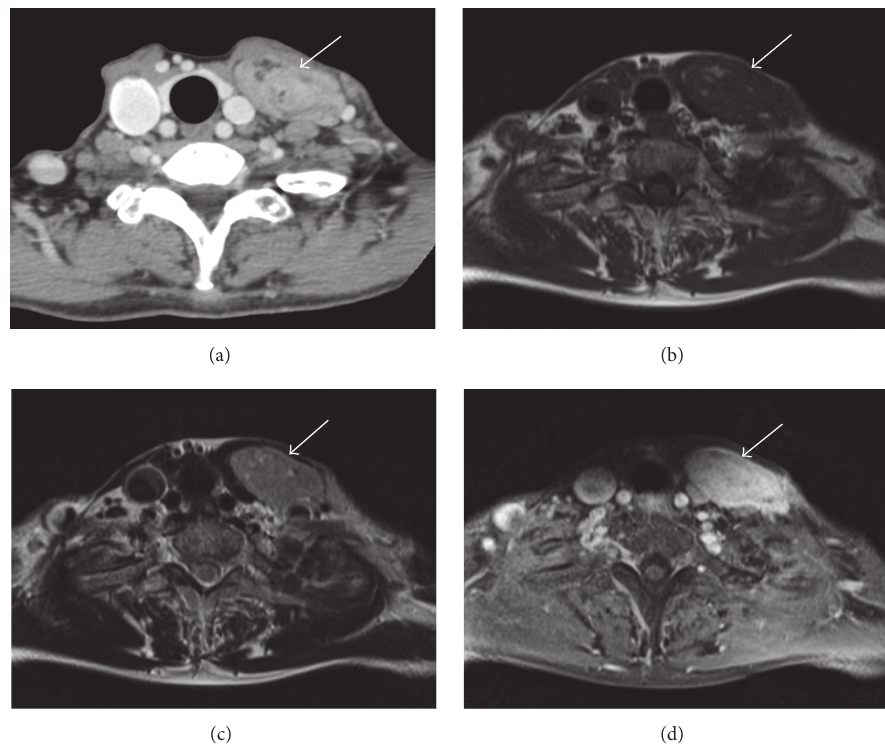
Figure 1: Preoperative imaging findings for Case 1. (a) Contrast-enhanced computed tomography image. T1-weighted axial (b), T2-weighted axial (c), and fat-suppressed gadolinium-enhanced T1-weighted axial (d) magnetic resonance images. Computed tomography and magnetic resonance images show a soft tissue tumor with adipose tissue between the sternocleidomastoid muscle and the anterior strap muscle.